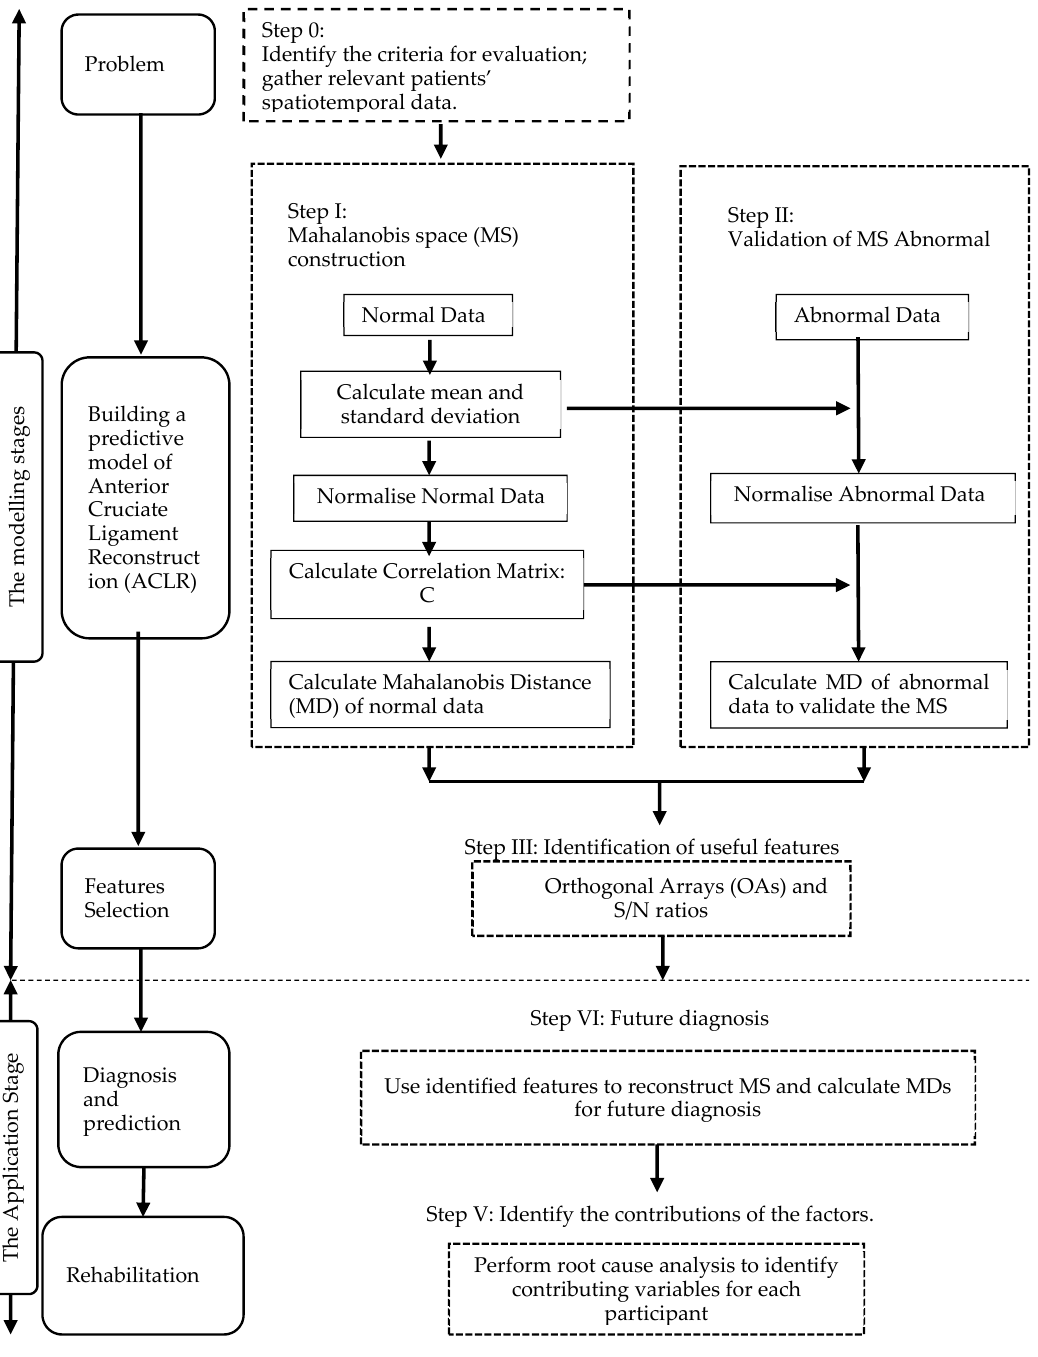
Figure 2. Flow chart of the approach proposed in this study.